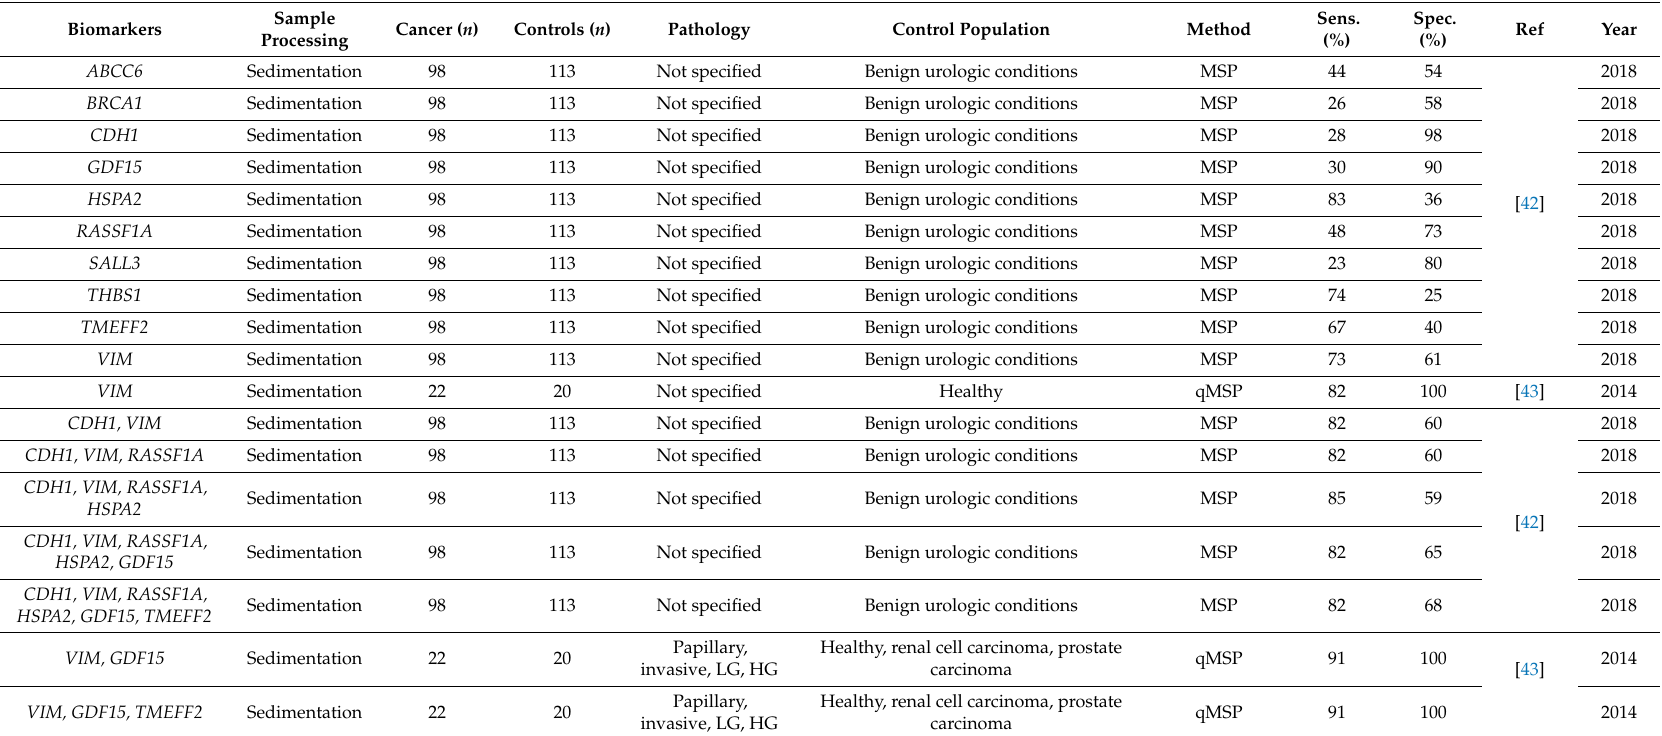
Table 5. DNA methylation biomarkers and biomarker panels for detection of upper urinary tract